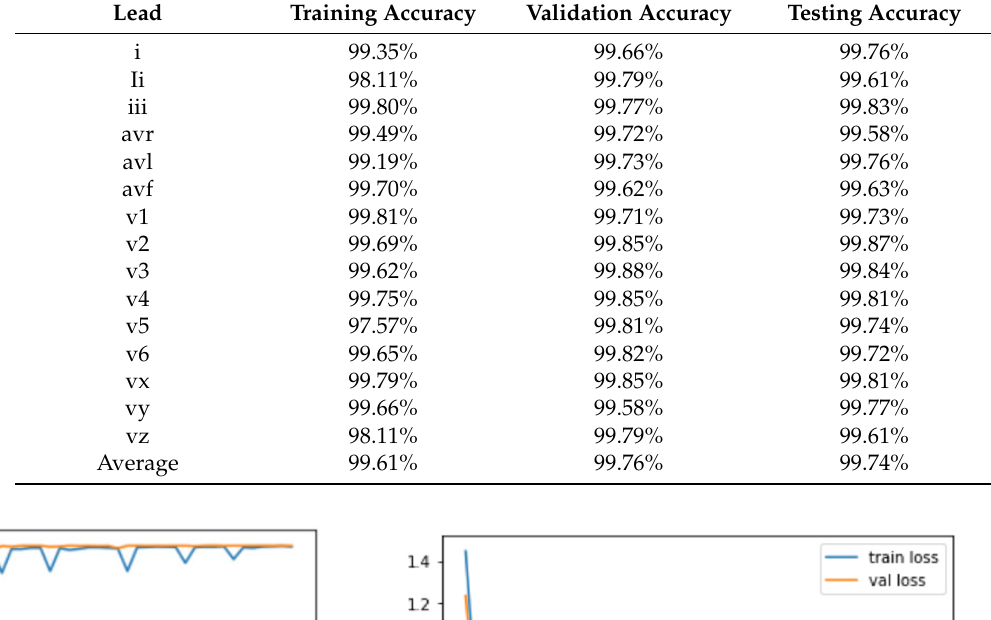
Table 3. The accuracy of the trained CNN model on the test data. Lead